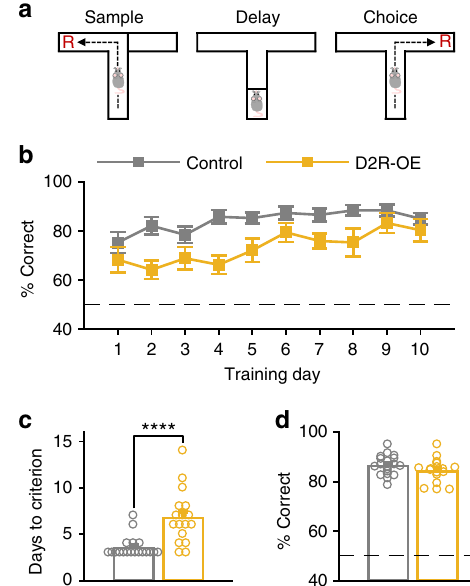
Fig. 1 D2R-OE mice are impaired on a spatial working memory task. a Schematic of working memory task. During the “ sample ” phase animals were directed to enter one of the goal arms of the maze. After a brief delay period, in the “ choice ” phase they had to enter the opposite arm to obtain a reward (R). b % correct choices during each day of training in D2R-OE and control mice. c Days required to reach criterion performance ( ≥ 70% correct choices over three consecutive days) in the two groups. D2R-OE